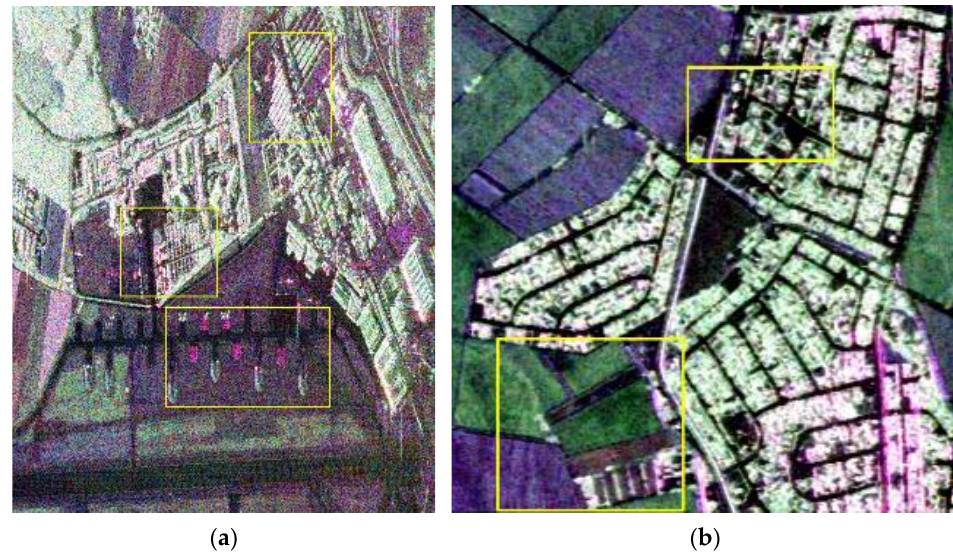
Figure 4. Pseudo-color images of Pauli decomposition. ( a ) ESAR image. ( b ) AIRSAR image.